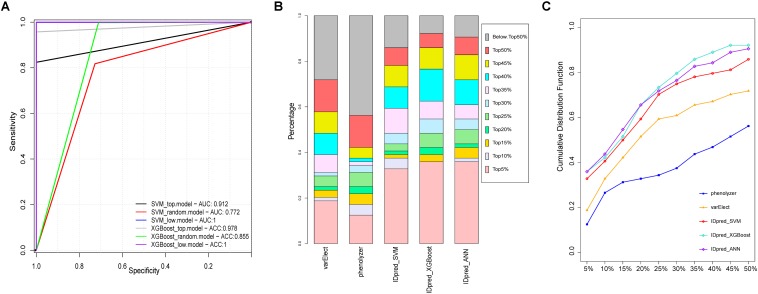
Performance comparison of pathological gene prediction between IDpred and other algorithms. (A) ROC curve derived from IDpred model based on 10 fold cross validation. (B) the percentage of predicted pathogenic gene derived from IDpred, phenolyzer, and varElect. (C) cumulative distribution of TopN rate base on the rank of the pathogenic gene derived from IDpred, phenolyzer, and varElect.